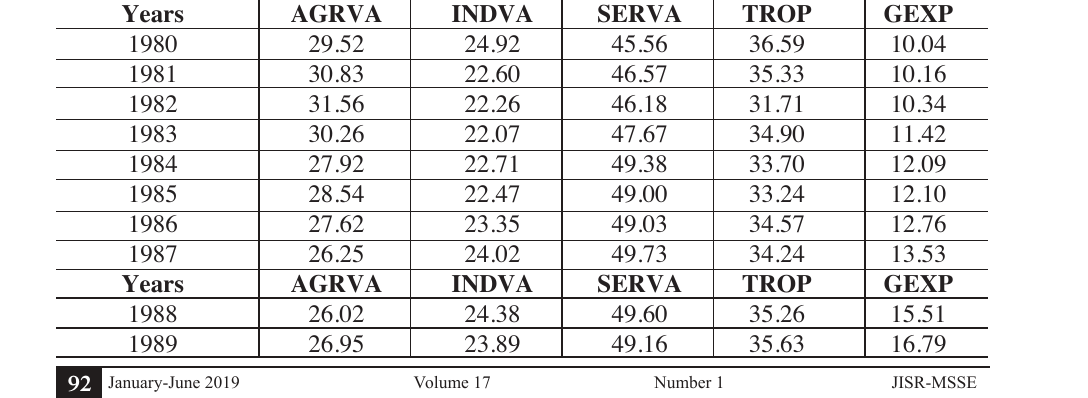
Data on Sector-wise Value-Added